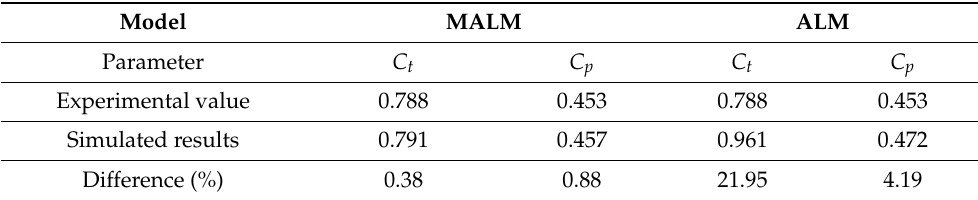
Table 5. Power and thrust coefficients of the G1 wind